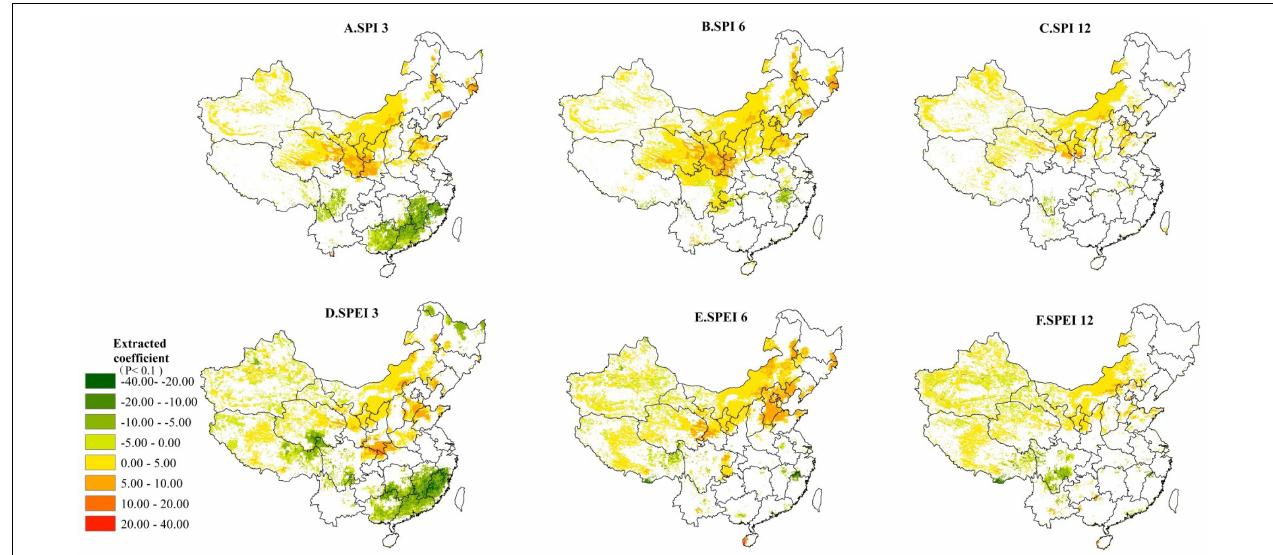
FIGURE 6 | The contributions (unit: gC/m 2 per unit of drought index) of SPI/SPEI to monthly NPP as defined by Eq. 6 in Supplementary Section S4.4 . (A) SPI3 contributions, (B) SPI6 contributions, (C) SPI12 contributions, (D) SPEI3 contributions, (E) SPEI6 contributions, and (F) SPEI12 contributions. Only 90% statistically significant pixels are plotted